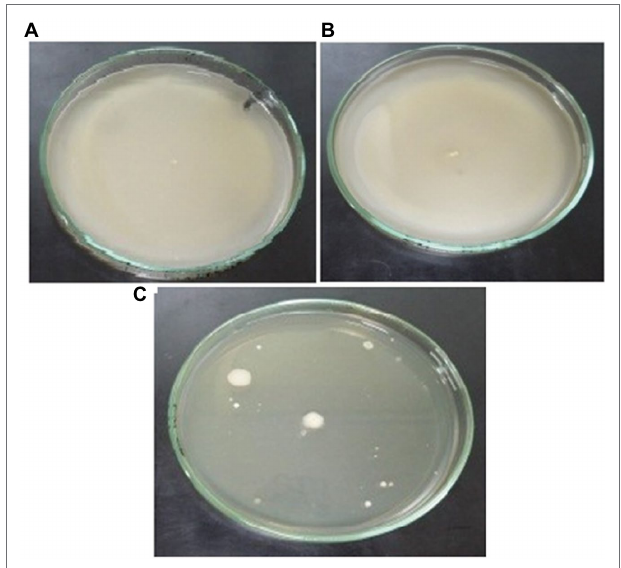
FIGURE 6 | Motility patterns of (A) swimming, (B) swarming, and (C) twitching behavior of B. altitudinis MT422188 with Cu (10 mg/l).